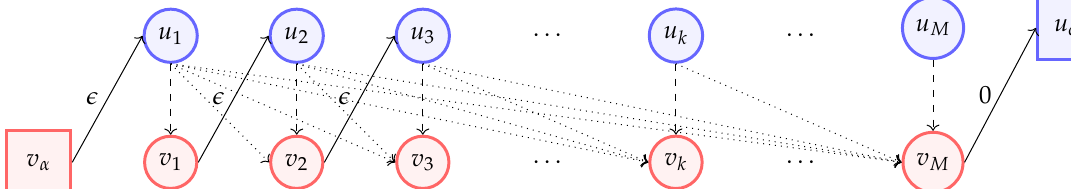
Figure 8. The directed acyclic bipartite graph for solving the multi-parameter Rice encoding problem. Each pair of u k and v k vertices represents the start and end of a sub-sequence in the basis (see Algorithm 2). The edges represent all possible ways of grouping the input data into larger sub-sequences. Edge costs are equal to the minimum bit-length of the sub-sequence w (see Algorithm 3) or to the overhead bit-length caused due to adding an extra sub-sequence to the solution ( (cid:101) ). The solution to the problem is given by the shortest path from v α to u ω